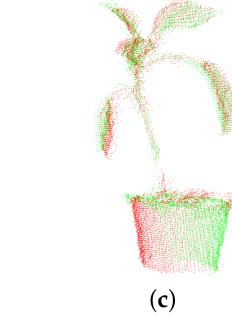
Figure 5. Comparison registering Pos 0 and Pos 1 point cloud by traditional ICP algorithm with our algorithm. ( a ) Pos 0 and Pos 1 point cloud. ( b ) Registering Pos 0 and Pos 1 point cloud by traditional ICP algorithm. ( c ) Registering Pos 0 and Pos 1 point cloud by our ICP